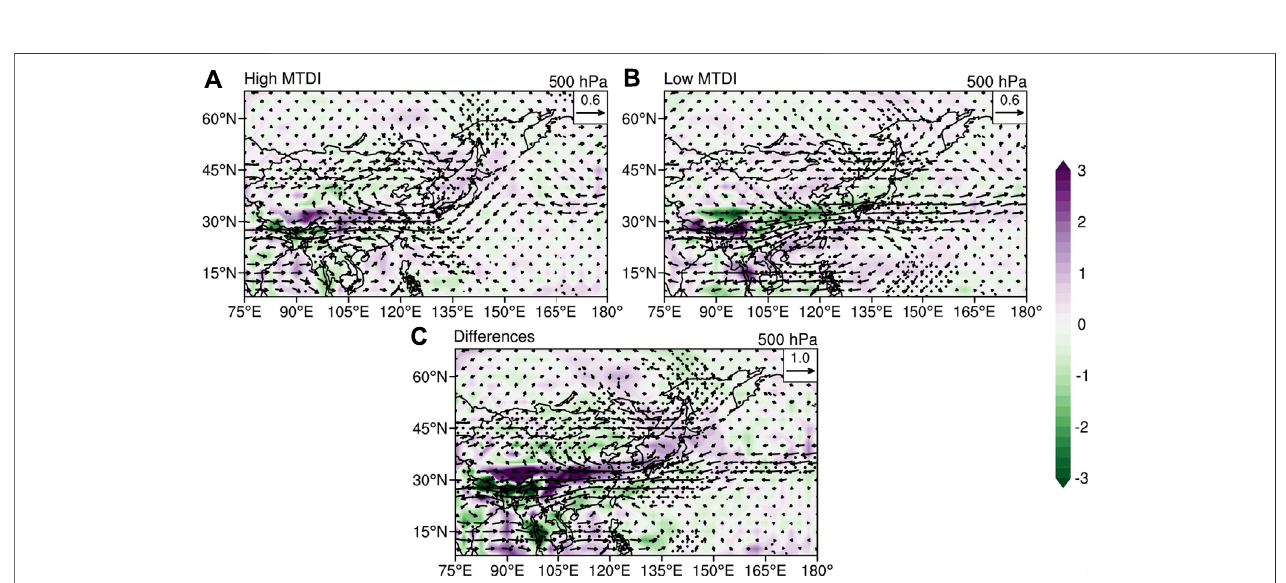
FIGURE 6 | Composites of JJA water vapor fl ux (vector; kg m − 1 s − 1 hpa − 1 ) and moisture fl ux divergence (shading; 10 – 6 kg m − 2 s − 1 hpa − 1 ) at 500 hPa levels in (A) high MTDI years, (B) low MTDI years and (C) their differences during 1950 – 2016. The dotted area refers to the place where the student ’ s t-test exceeds the 95% signi fi cance level.